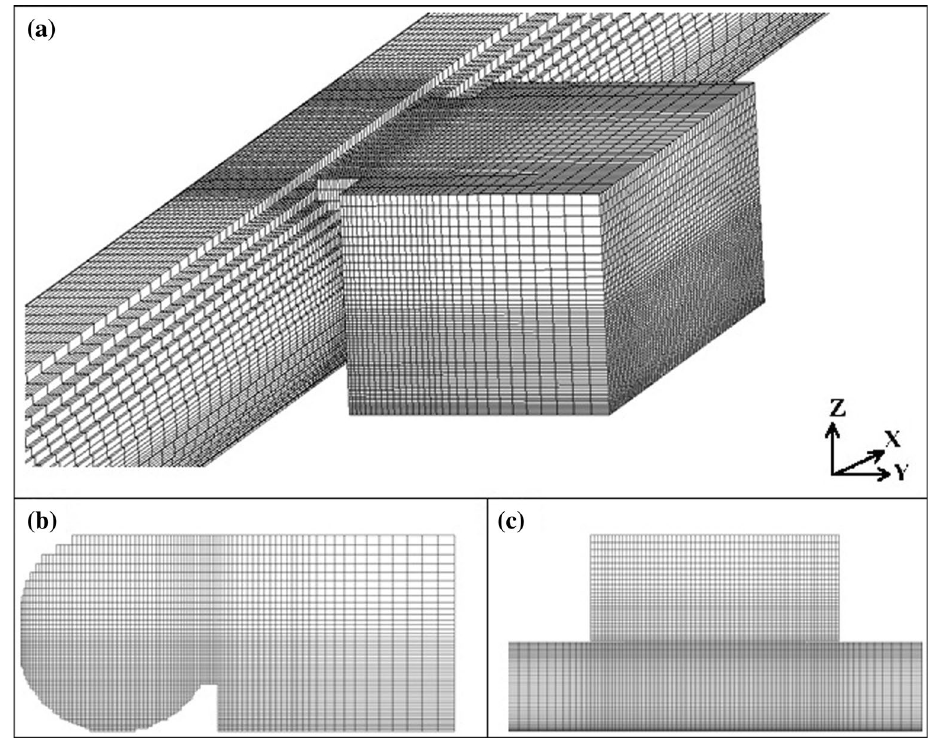
Fig. 3 Computational field grid- ding a 3D view, b cross section,